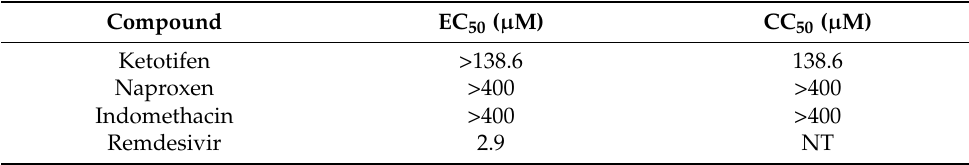
Table 1. EC 50 and CC 50 data from the CPE assay.